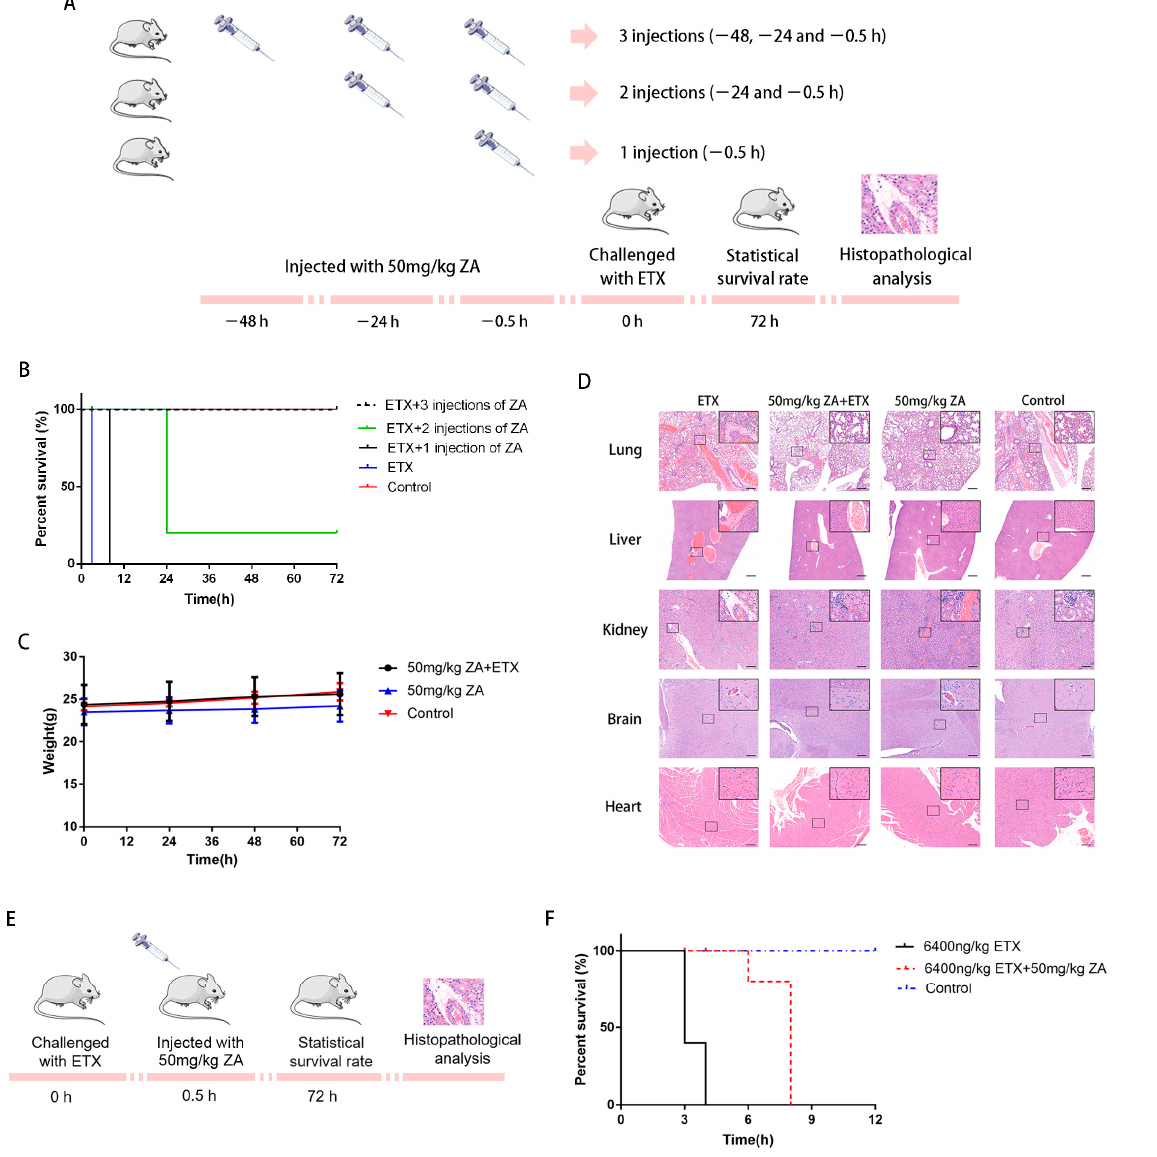
Figure 5. ZA can protect mice against ETX. ( A ) Mice were injected with 6400 ng/kg ETX 30 min after the administration of a first, second, or third dose of ZA. Mice in the control group were injected with PBS. The survival rate ( B ) and the weight ( C ) of mice after injections with ZA for 2 days, followed by ETX challenge and then observed for 72 h. ( D ) Sections were made from various organs of the challenged mice, stained with hematoxylin and eosin (H & E). Photographs of the sections were taken using a bright field microscope with a digital camera. Scale bar: 100 µ m. ( E , F ) Mice were injected with 50 mg/kg ZA 30 min after being challenged with 6400 ng/kg ETX.